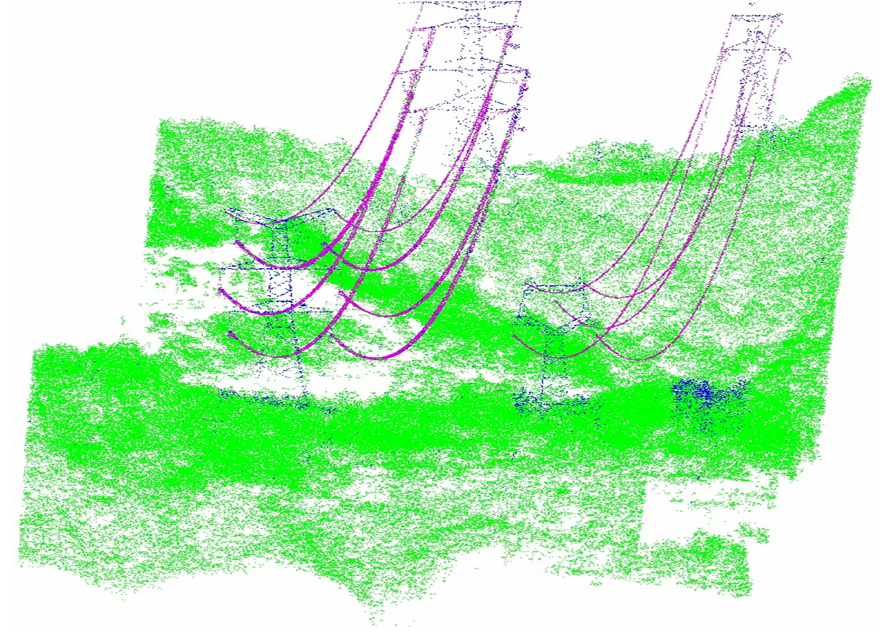
Figure 6. Classification results. For simplification, the ground and building points are not shown in this figure. (color legend: trees, green; power-lines, violet; and pylons, blue). The classes of major points are correctly identified using the classification algorithm [21].